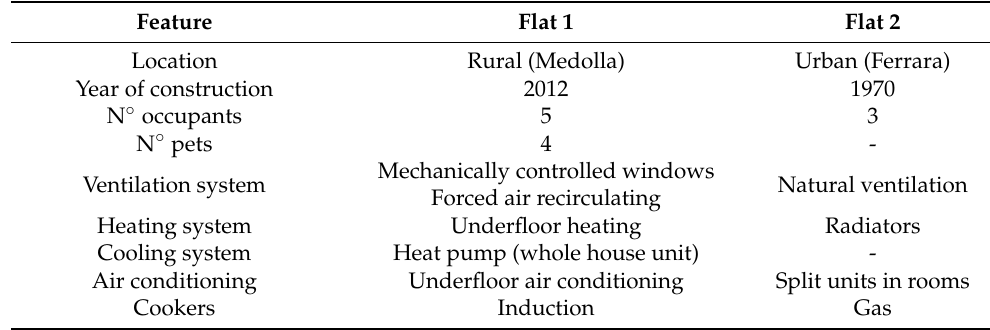
Table 1. Features of dwellings monitored in the